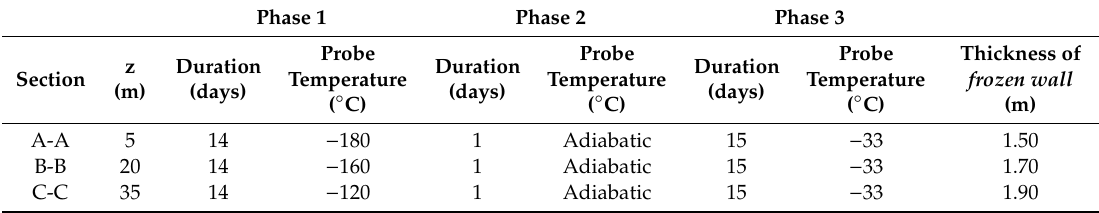
Figure 10. Comparison between field emission microscopy (FEM) analysis and Colombo [5].